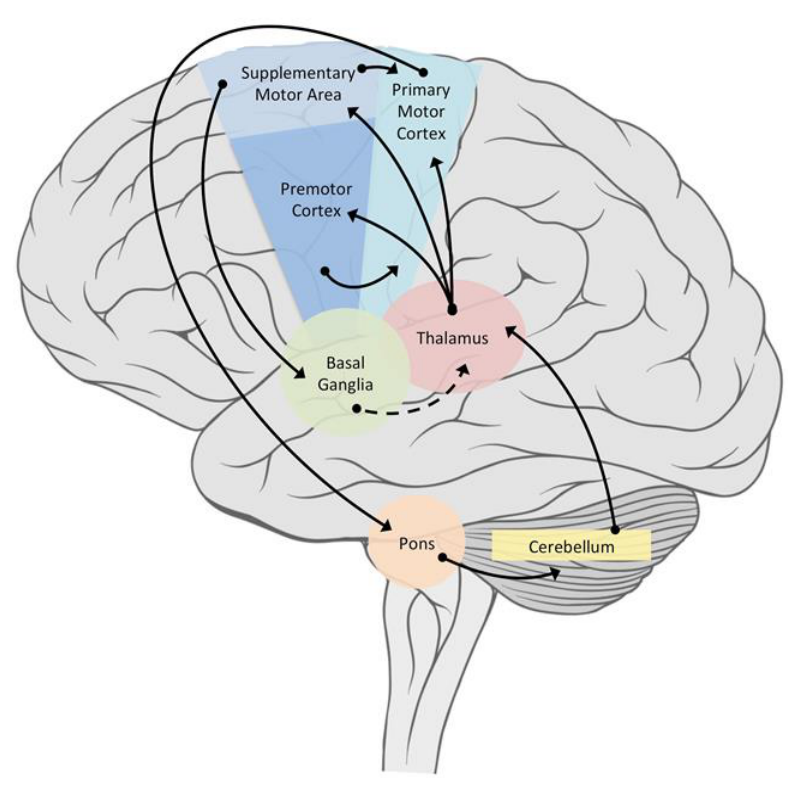
Figure 5. Connectivity in the brain among principal areas responsible for the motor control and coordination of complex rhythmic activities. Solid line = excitatory projections. Dashed line = inhibitory projections. Note that PFC and some parietal areas (not shown) are also important for maintaining different coordination patterns (goals and sensory monitoring) to determine if goals are being maintained.